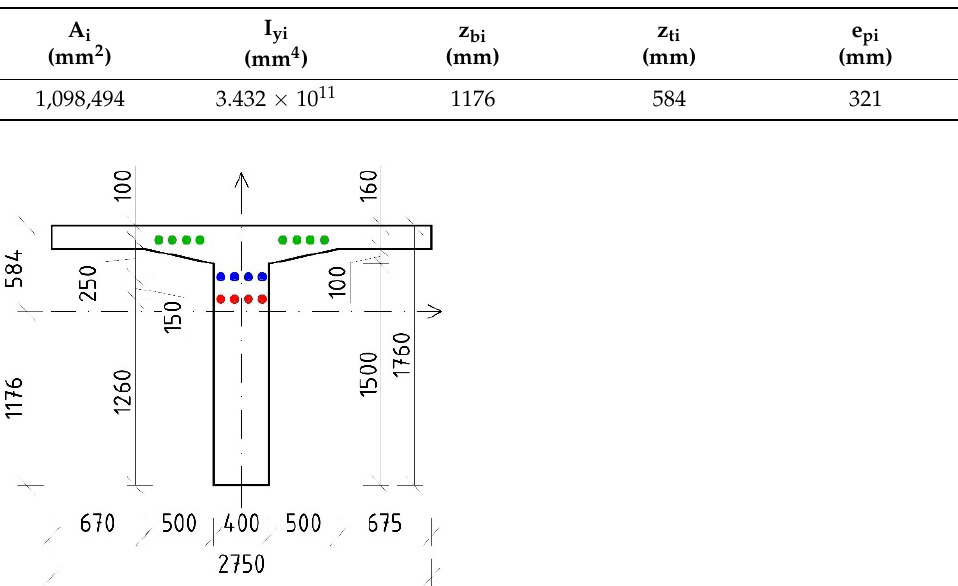
Figure 21. Measured normal stress relief after application of saw-cuts (SG2 was damaged). Table 4. Ideal cross-sectional characteristics (2.50 m from the strut).